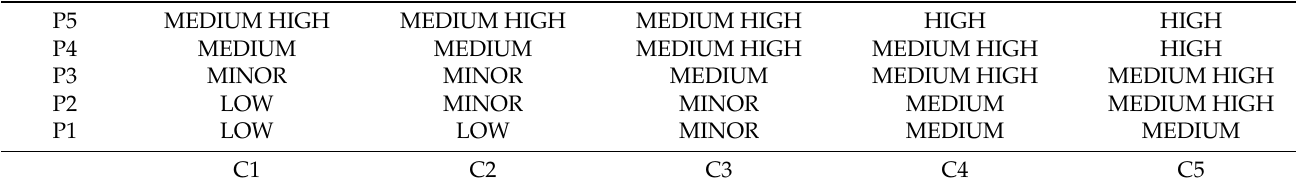
Table 6. Risk decision matrix.